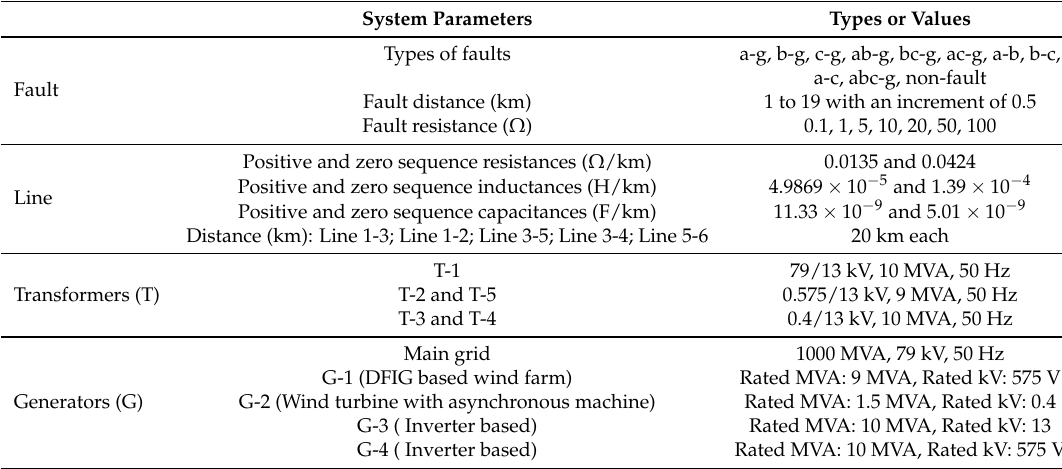
Table 1. Specification of the system parameters.